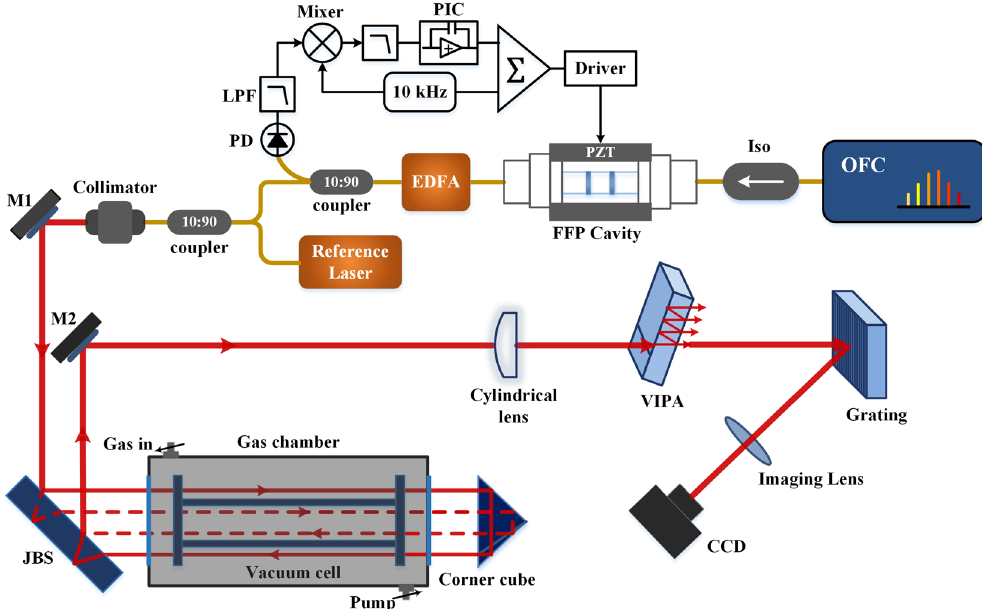
Figure 1. Experimental apparatus of the proposed gas refractometer. Iso: isolator; PD: photodetector; LPF: low- pass filter; M1, M2, mirror. The red line denotes the light beam propagating in the free space (the dotted line represents the light beam transmitting inside the vacuum cell), the yellow line illustrates the light beam passing through the optical fiber, and the black line denotes electrical